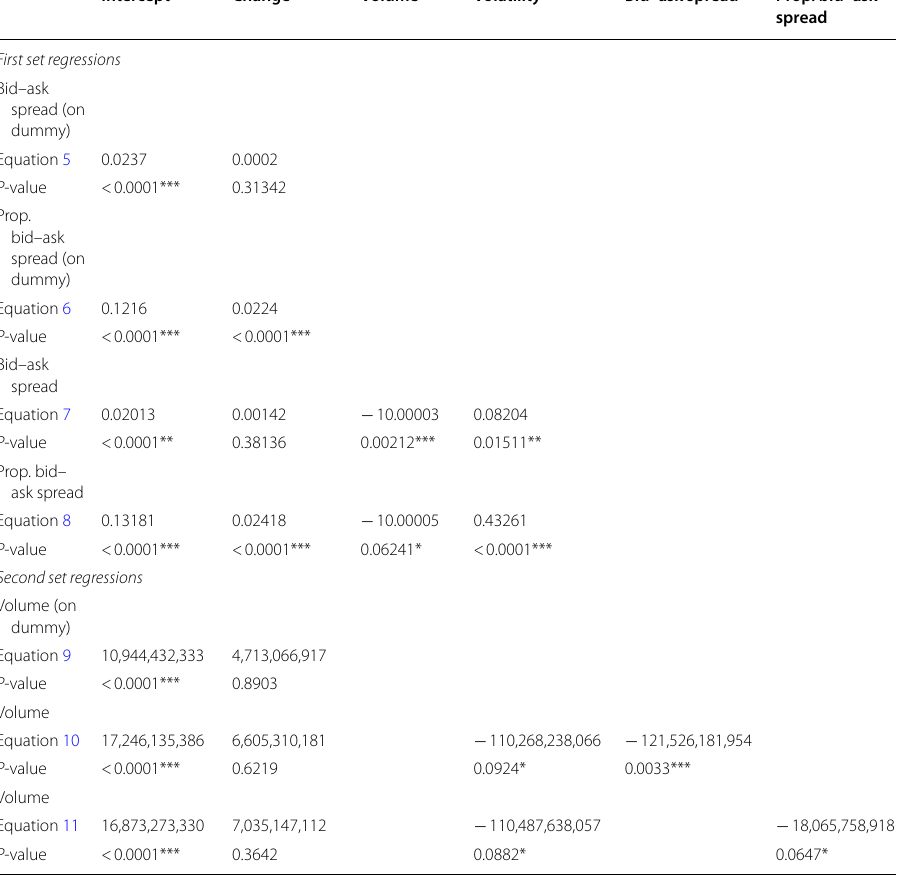
Table 5 The event period’s regression